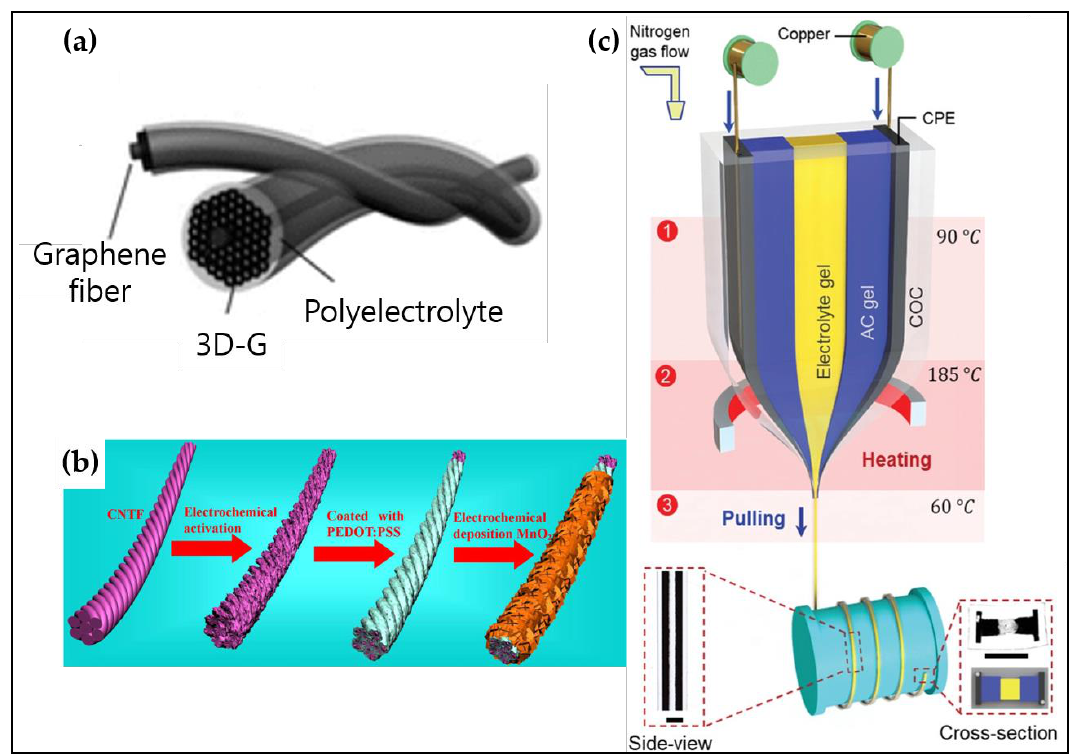
Figure 8. Schematic illustration of representative fiber-based supercapacitors. ( a ) Carbon-based supercapacitor fiber. Reproduced with permission from [146], Copyright (2013), Wiley. ( b ) Metal oxide-based supercapacitor fiber. Reproduced with permission from [49], Copyright (2017), Elsevier Ltd. ( c ) The longest supercapacitor fiber fabricated by the TDP. Reproduced with permission from [53], Copyright (2020), Wiley.